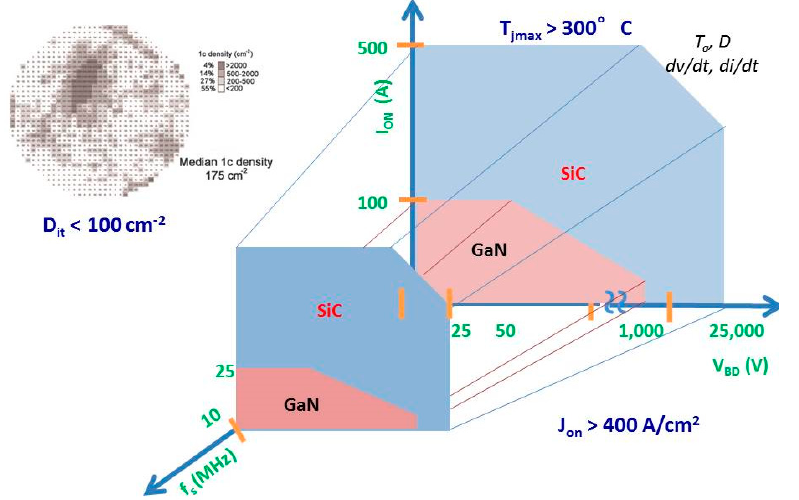
Figure 4. The projected safe-operating area (SOA) of SiC and GaN power devices; the SOA for GaN is expected to be smaller than that of SiC due to a higher density of crystal defects in the material.